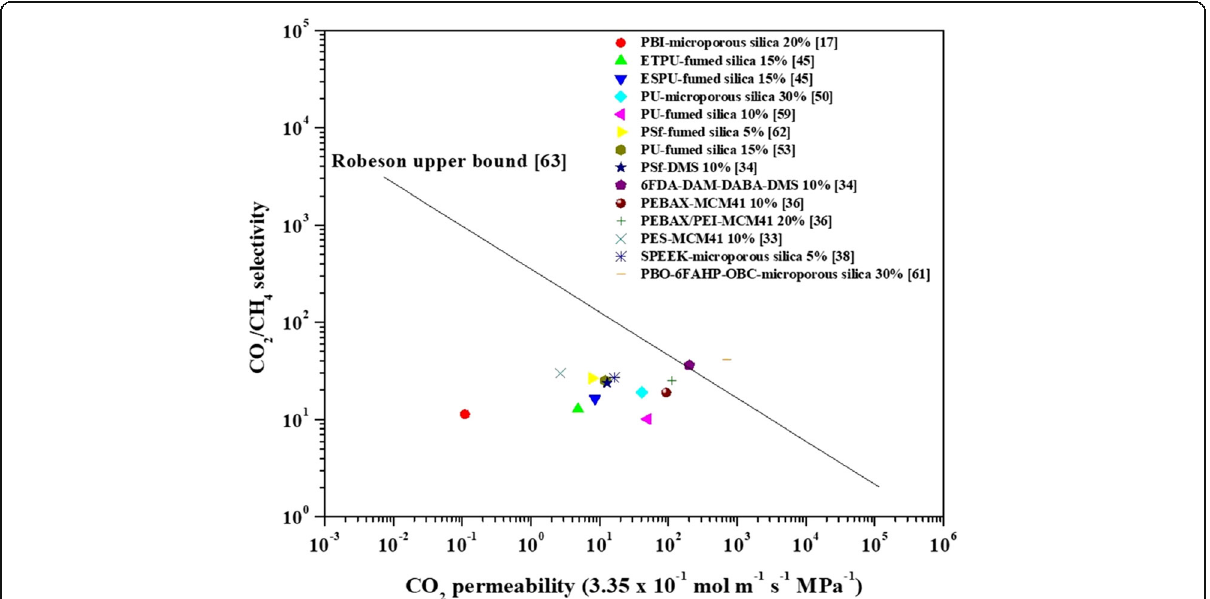
Fig. 14 CO 2 / CH 4 selectivity of MMMs compared to Robeson upper bound [63] (PBI: polybenzimidazole; ETPU: polyetherurethane; ESPU: polyesterurethane; PU: polyurethane; PSf: polysulfone; 6FDA-DAM-DABA: (4,4 ’ hexafluoroisopropylidene diphthalic anhydride) – (2,4,6-trimethyl-1,3- diaminobenzene) – (3,5-diaminobenzoic acid); PEBAX: polyether block amide; PEI: polyethyleneimine; PES: polyethersulfone; SPEEK: sulfonated polyether ether ketone; PBO-6FAHP-OBC: (polybenzoxazole) – (2,2-bis 3-amino-4-hydro-xyphenyl hexafluoropropane) – (4,4 ′ -oxybis